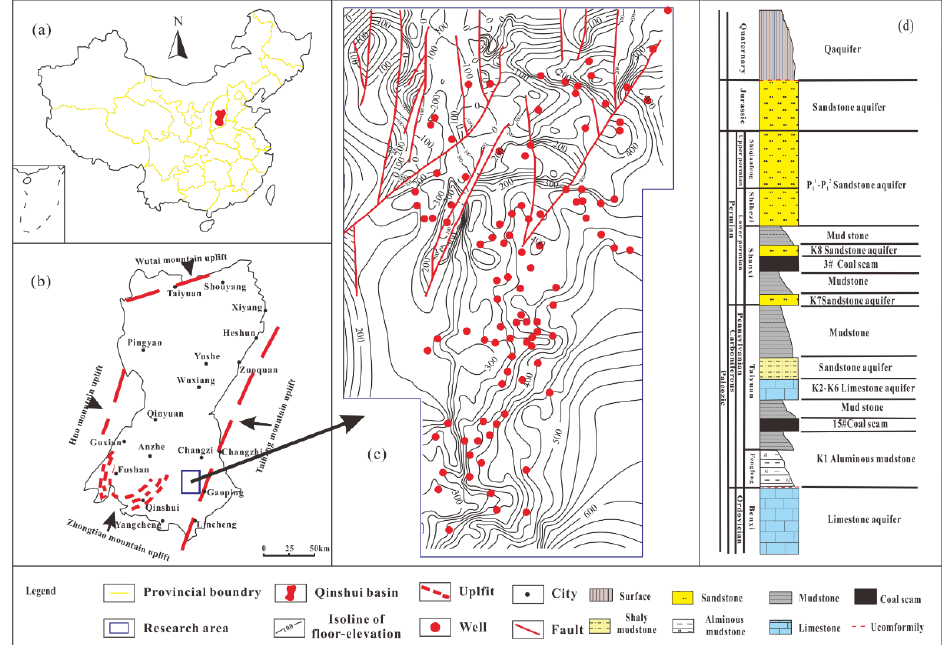
Figure 1. Location of the study area and wells. ( a ) Location of the study area in China. ( b ) Location of the Shizhuangnan Block in southern Qinshui Basin. ( c ) Topography of the study area and location of the wells. ( d ) Stratigraphic column of the coal-bearing strata.